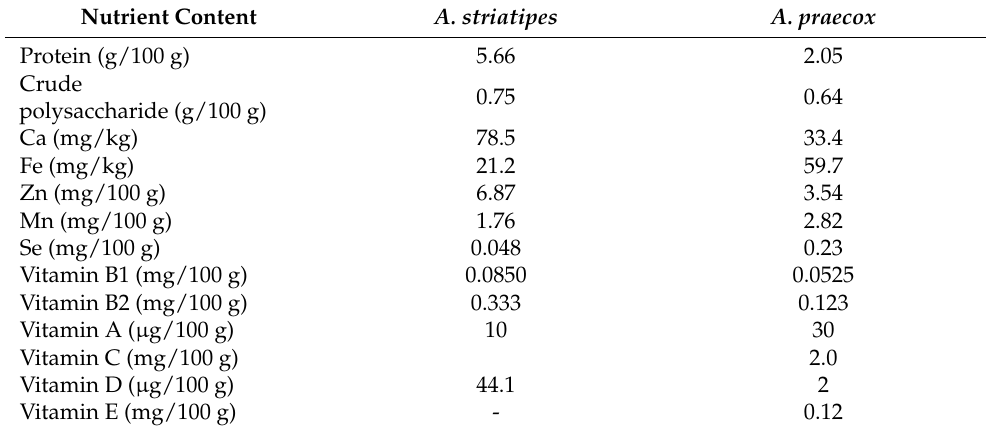
Table 2. Vitamins and elements content of A. striatipes and A. praecox (g/100 g dry weight). Missing data are indicated by “-”.